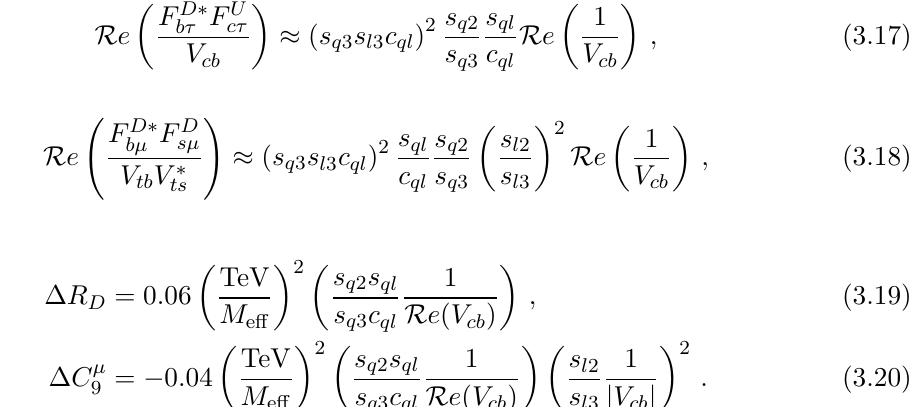
= 5 , 7 . 5 , 10 , 15 , 20 D { = s e | V cb | l 2 /s l 3